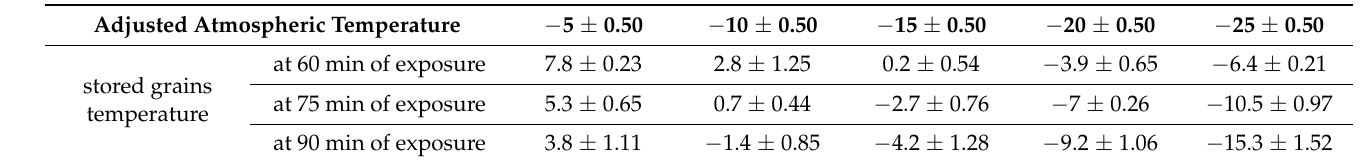
Table 1. Stored grain temperature [mean ( ◦ C) ± SE] recorded as a function of set atmospheric temperatures and exposures ( n = 4).